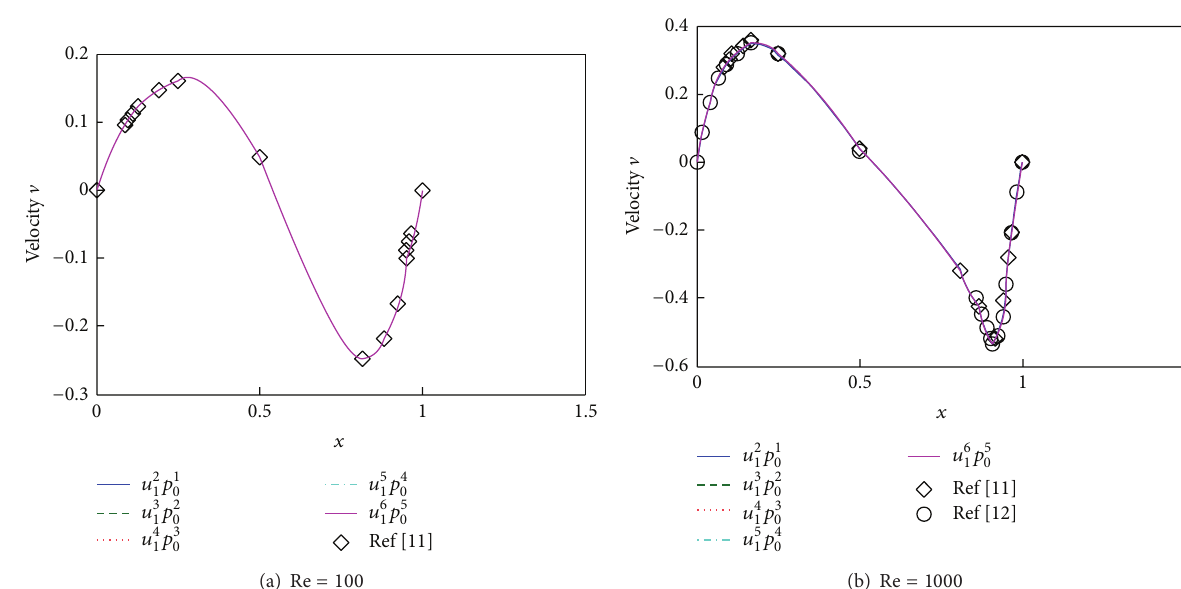
Figure 7: Streamline distribution of fluid ( 𝑝 = 3 , 𝑁 = 20 ).